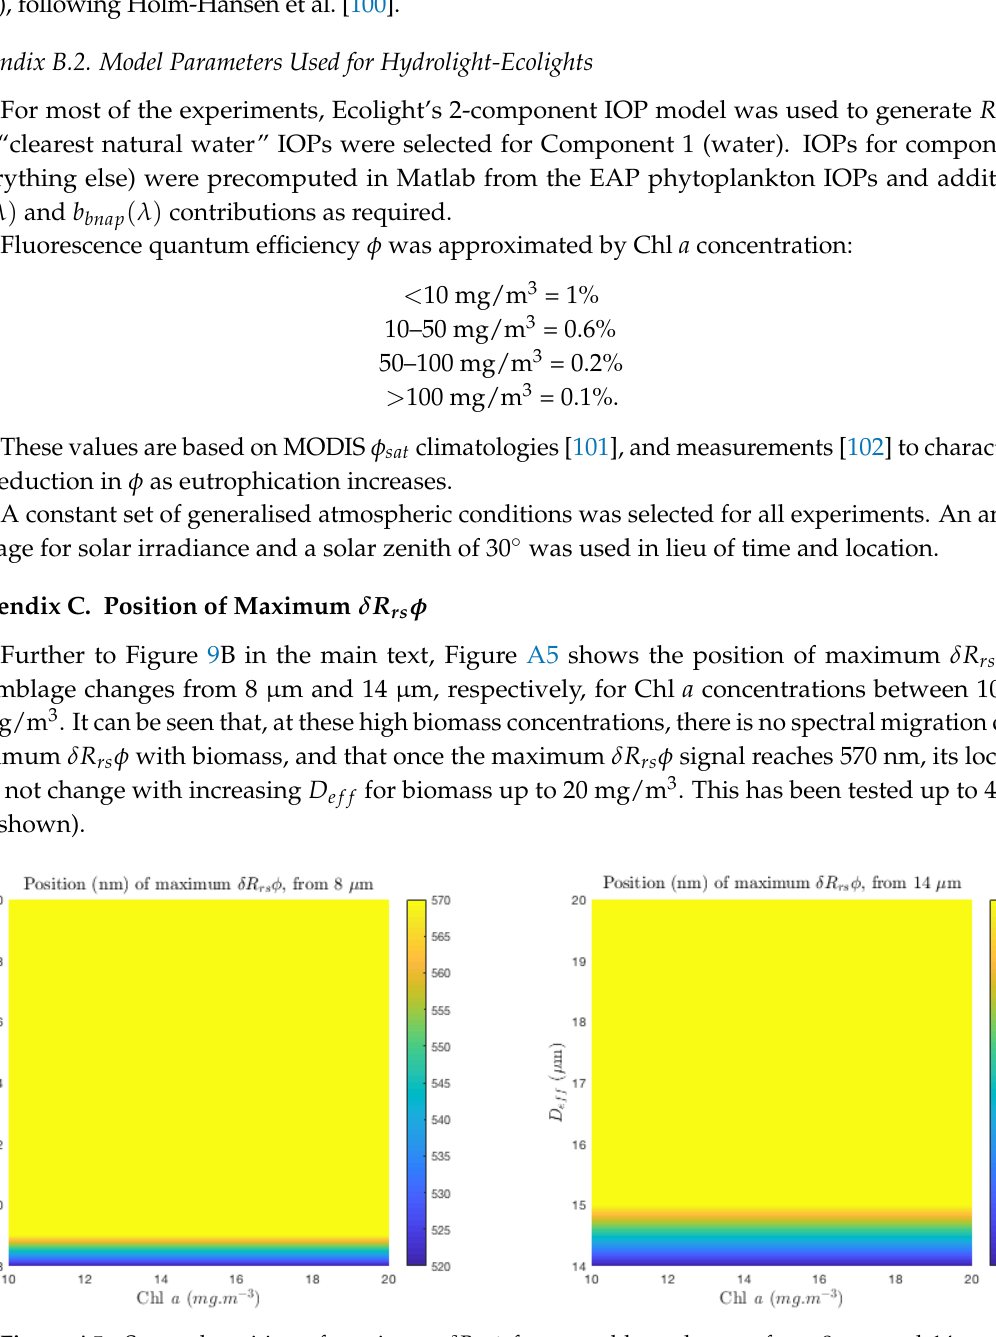
Figure A5. Spectral position of maximum δ R rs φ for assemblage changes from 8 µ m and 14 µ m,